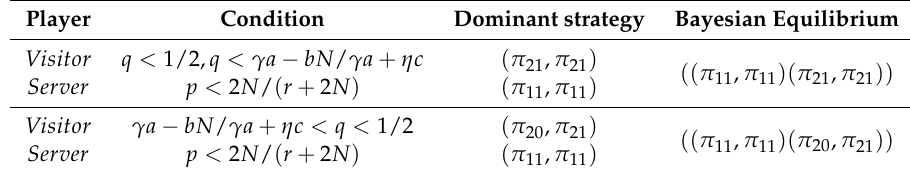
Table 10. List of Bayesian equilibriums for all players when p < 2 N / ( r + 2 N ) .